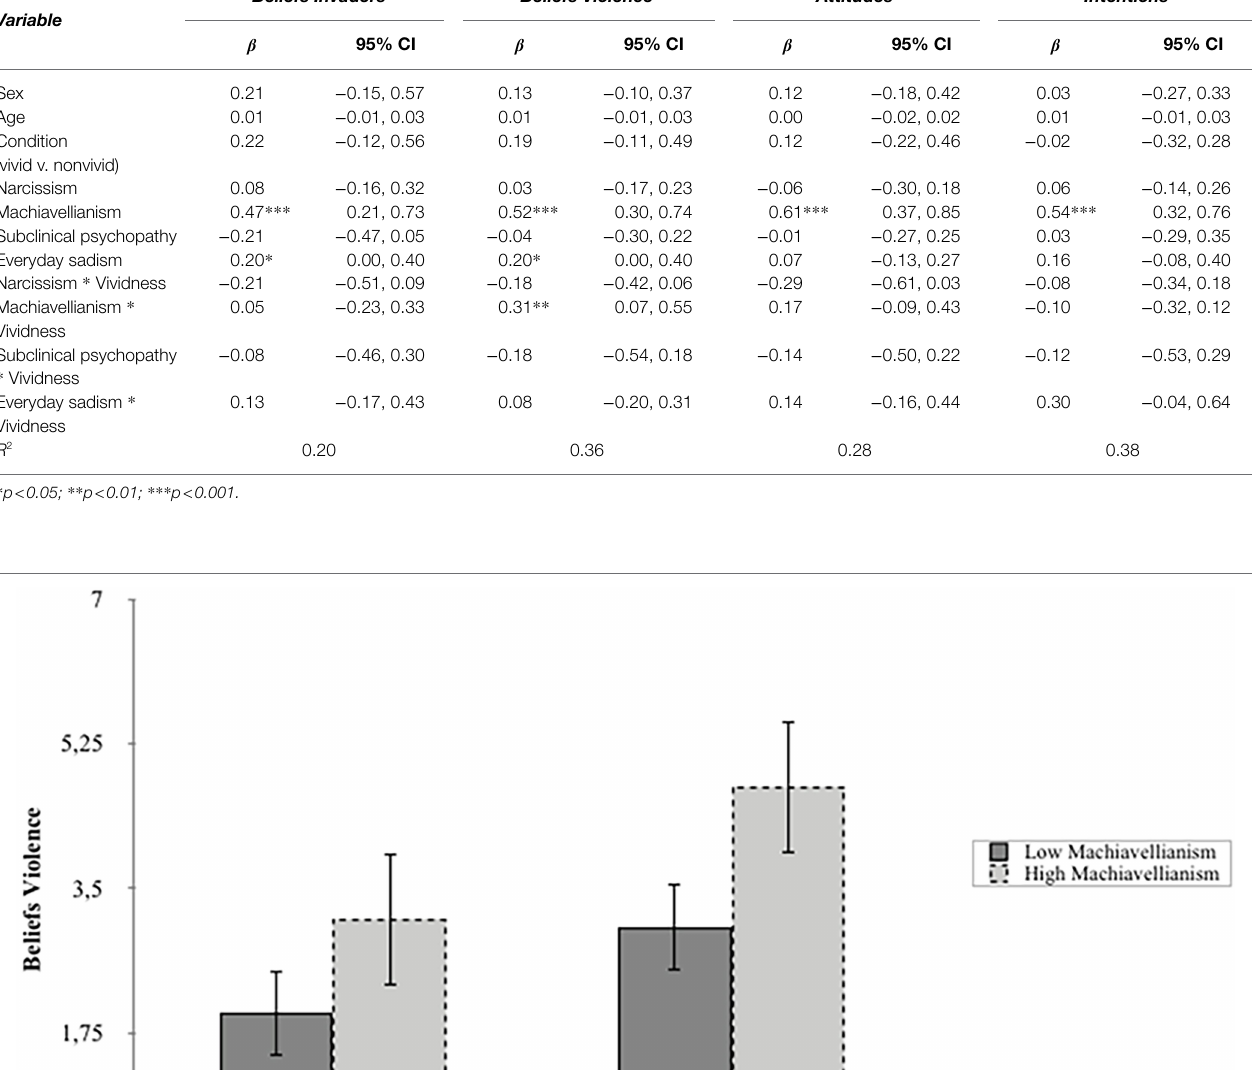
TABLE 5 | Main and interaction effects of dark tetrad traits and narrative vividness on participant beliefs, attitudes, and intentions.